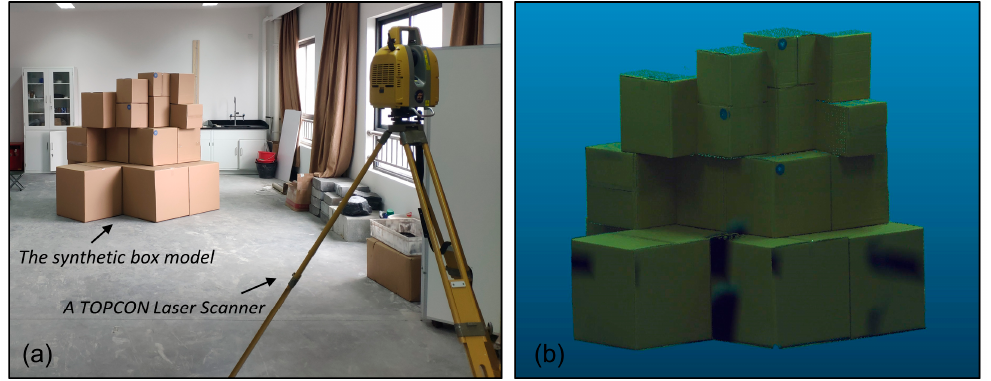
Figure 3. ( a ) Scanned cardboard boxes for experimental study; ( b ) 3D PCM of